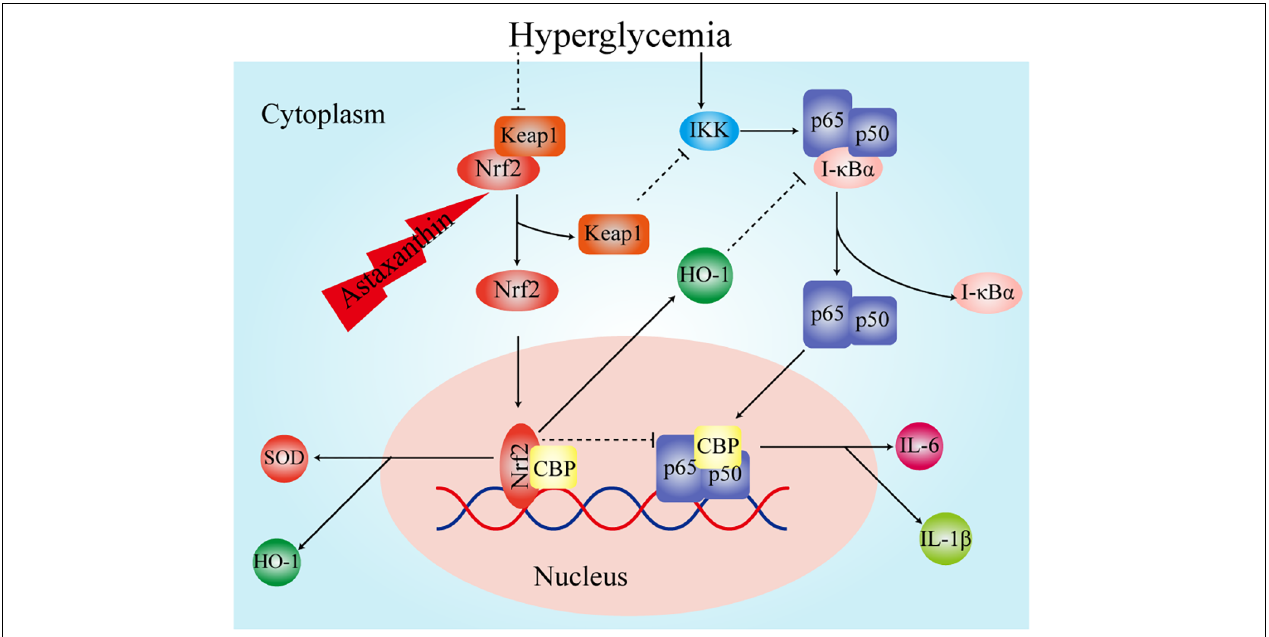
FIGURE 7 | The potential pathway of Nrf2 inhibiting oxidative stress and inflammatory response.